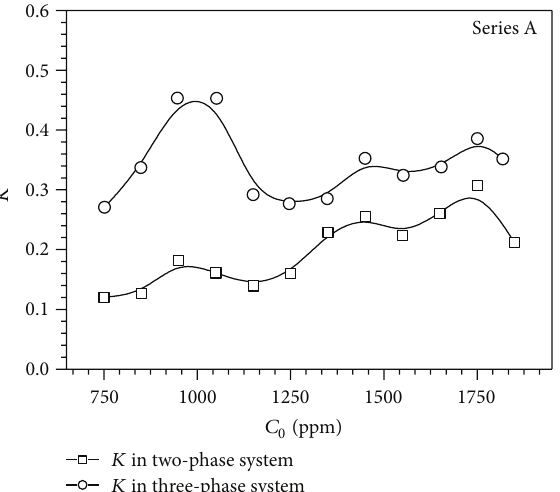
Figure 7: The distribution coefficient in water-oil system in the simulative water A.